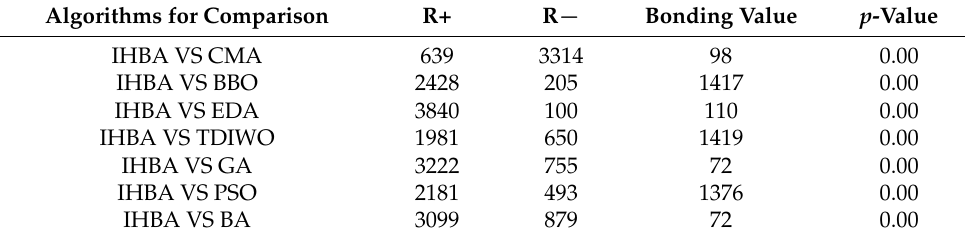
Table 12. The Wilcoxon paired signed test result at C = 60 and α =